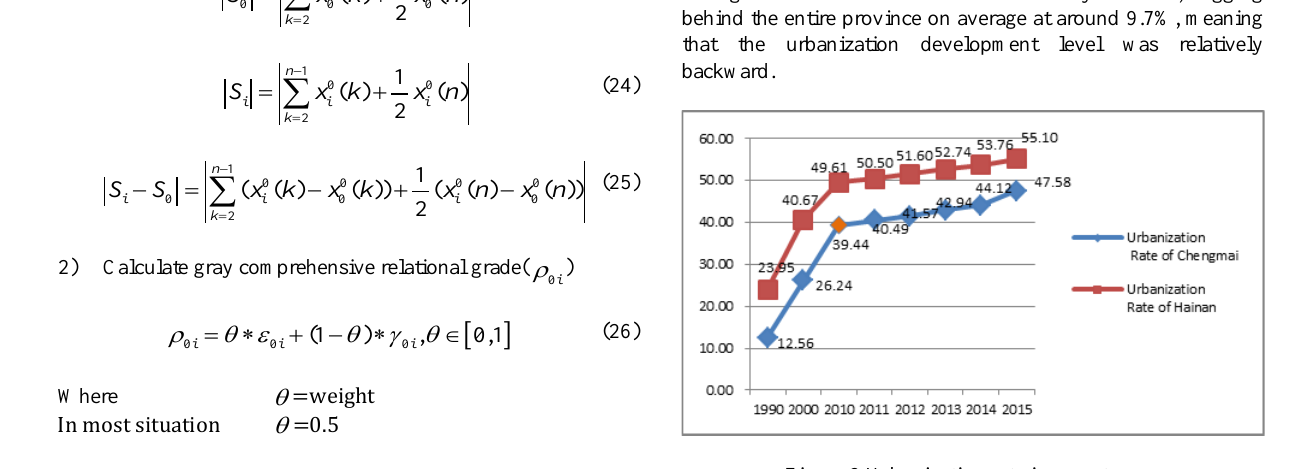
Figure 2.Urbanization rate in recent